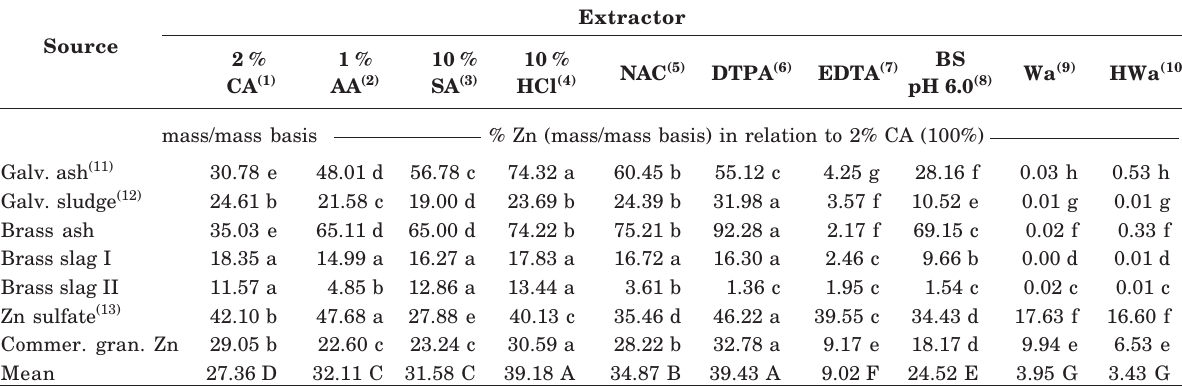
Table 5. Zn contents extracted by the 2 nd extractors in mineral fertilizers and industrial by-products